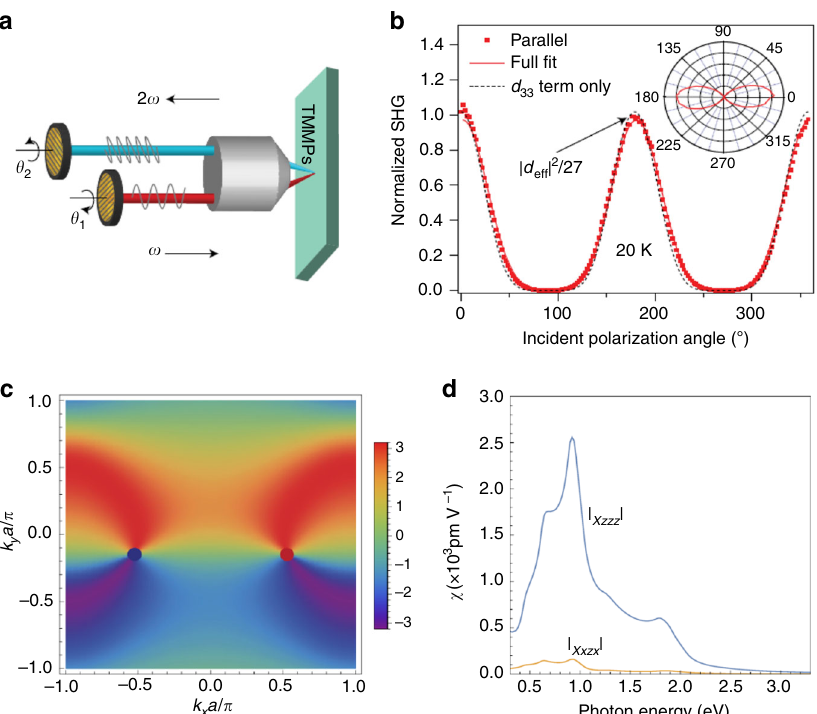
Fig. 6 Second-harmonic generation (SHG) in TaAs. a Schematic of the SHG experimental setup. b SHG intensity as a function of angle of incident polarization at 20 K. c Color plot of the momentum-resolved contribution to the SHG for a model for a simpli fi ed mode for TaAs. d The photon-energy dependence of SHG for a simpli fi ed model. Figures from ref 80 . Reprinted with persmission from Nature Publishing